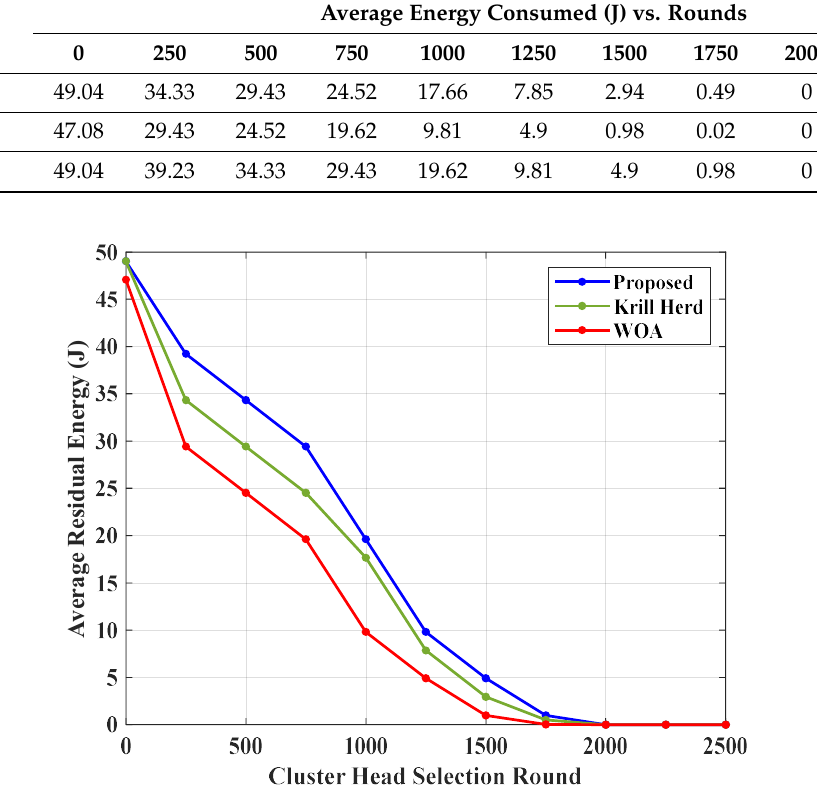
Figure 4. Comparison of CH selection by the proposed method with existing approaches. Table 3. Average residual energy consumption of the proposed ASFO algorithm. Average Energy Consumed (J) vs. Rounds